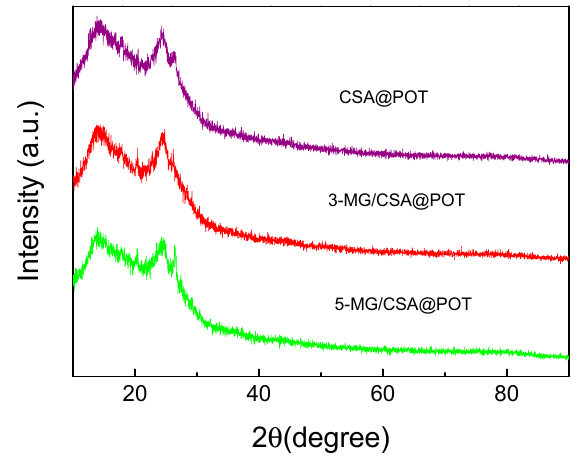
/ CSA@POT, and 5-MG /